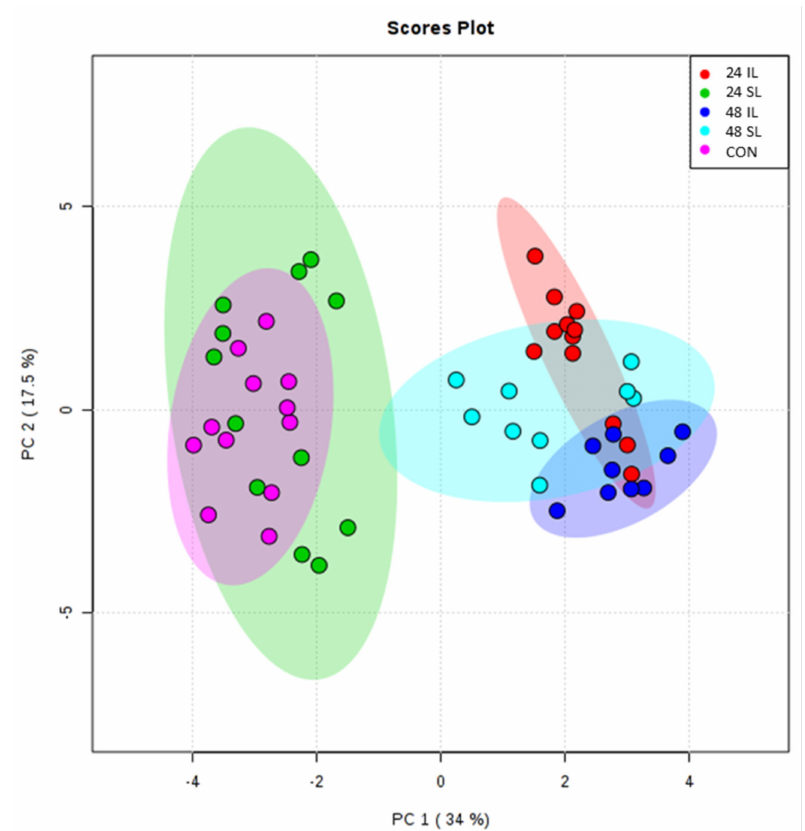
Figure 1. Principal Component Analysis of Phytophthora capsici challenged Black Pepper ( Piper nigrum L.) leaves. Leaves were sampled at the site of infection (IL) and in the leaf imme- diately above the infection site (systemic, SL) at 24 and 48 h after the challenge. Changes were compared to control; mock-inoculated leaves (CON). Larger ovals represent 95% confidence intervals for each